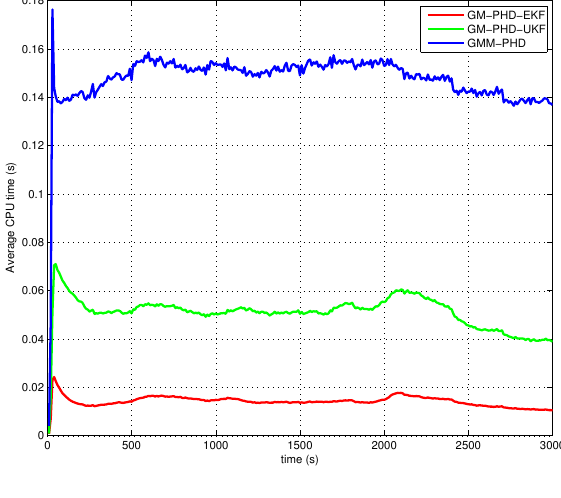
Figure 9. Execution